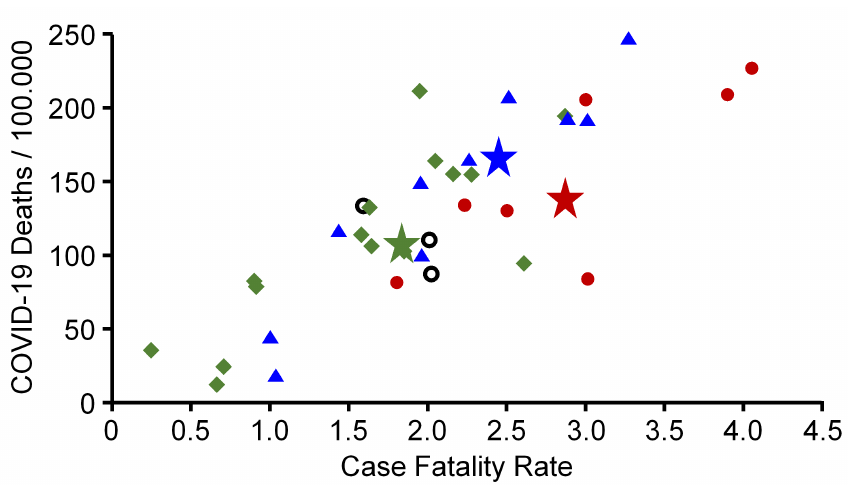
Figure 5. Cumulative COVID-19 associated death incidence per 100,000 inhabitants and cumulative case fatality rates of European countries with more than 1 million inhabitants. Stars (average) indicate the values for the total population of the corresponding cluster. Data were obtained on 13 April 2021 from the homepage of the World Health Organization [19]. Red circles, green squares, blue triangles = countries belonging to cluster 1, 2, and 3, respectively. Open black circles: countries belonging to no